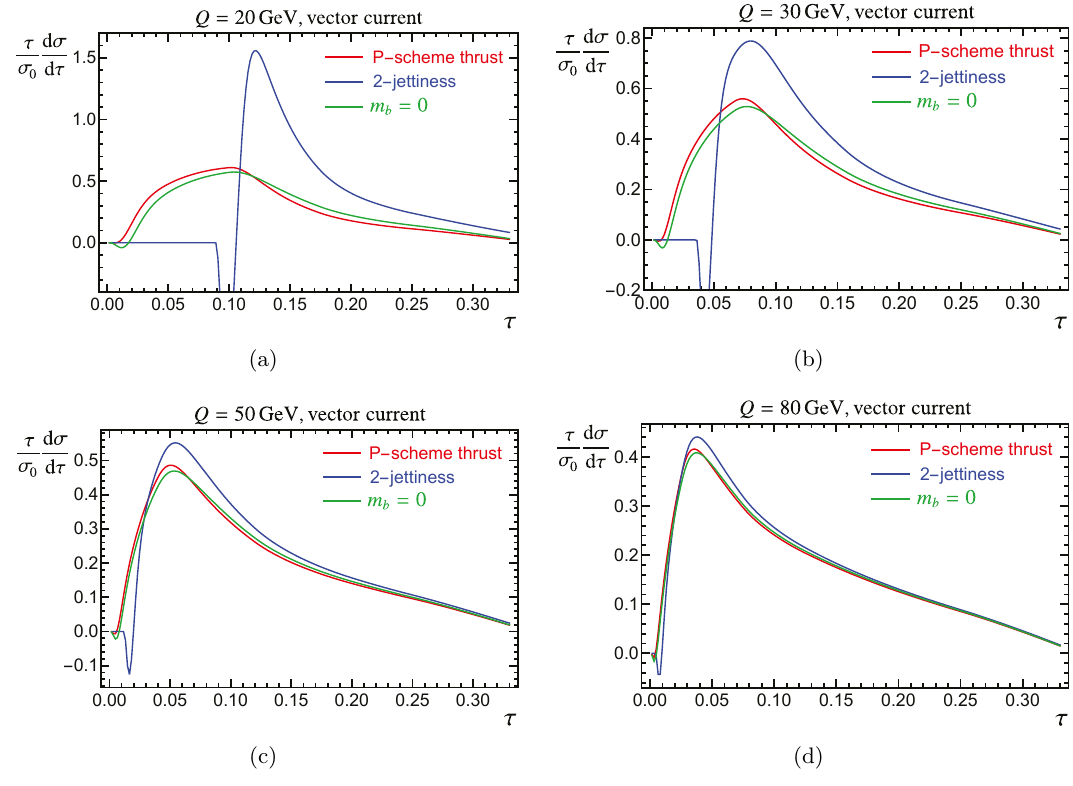
Figure 9 . Di(cid:11)erential cross section for massless quarks (green lines), 2-jettiness (blue lines) and P-scheme thrust (red lines) produced through the vector current. Panels (a), (b), (c) and (d) correspond to center-of-mass energies of 20, 30, 50 and 80 GeV,